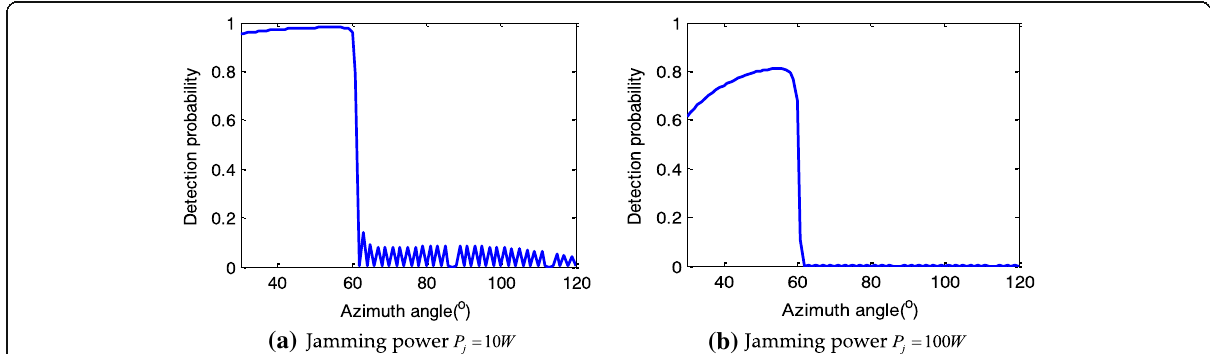
Fig. 12 Detection probability changes with different jamming power. a Jamming power P j = 10 W. b Jamming power P j = 100